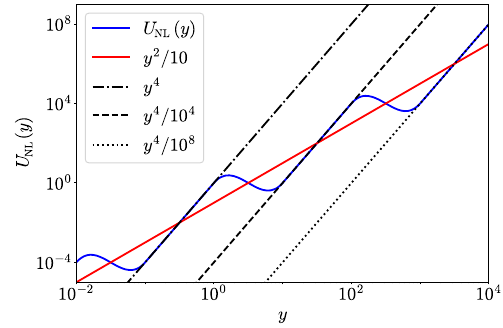
y Þ in Eq. (22) (blue) NL ð y Þ ∝ y 4 (indicated with NL ð